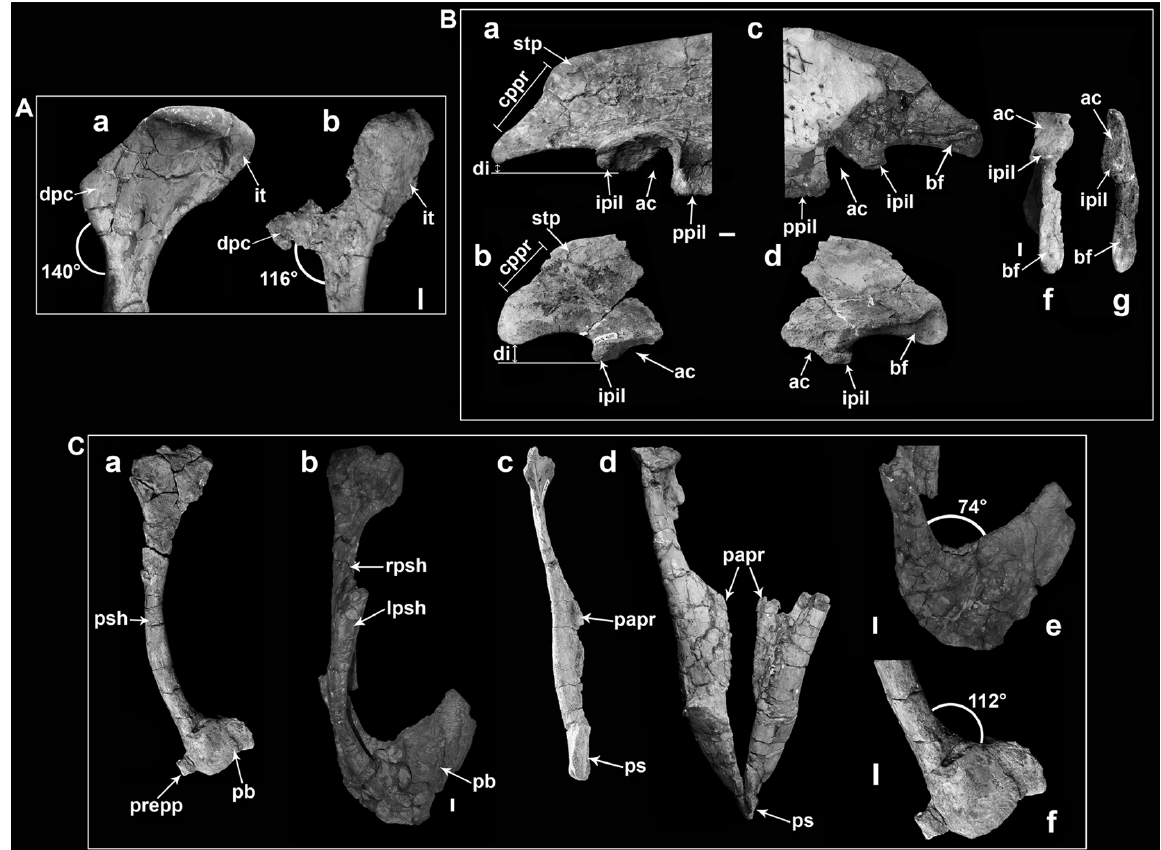
Fig. 4–Osteologicalcomparisonbetween U.comahuensis and U.paynemili ; thosedifferencesdiscussedbyCalvoetal. (2004)andthosediscussed in this paper are included. A : comparison of the proximal part of the left humerus of U. comahuensis (a) and U. paynemili (b) (observe the eroded surface of the deltopectoral crest); the angle between the deltopectoral crest and the shaft is marked. B : comparison of the posterior part of the ilium of U. comahuensis (a, c, e) and U. paynemili (referred material: MUCPv-409) (b, d, f); a and b: lateral views; c and d: medial views; e and f: ventral views. C : comparison between the pubes of U. comahuensis (b, d, e) and U. paynemili (holotype: MUCPv-349) (a, c, f); a: left